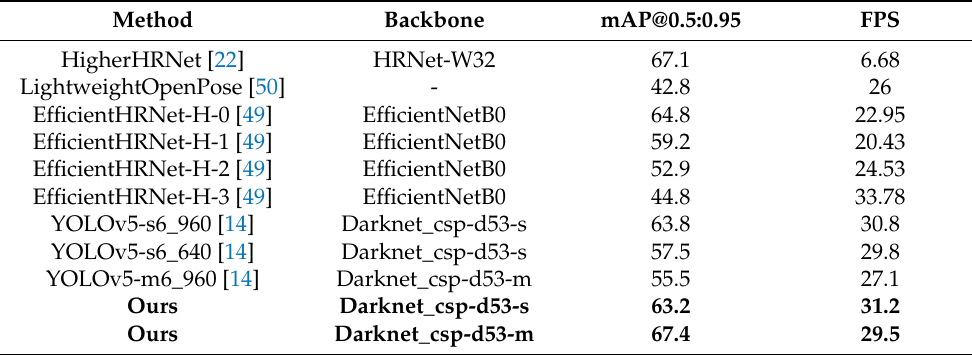
Table 4. Comparison of Network FPS and Average Accuracy between Our Model and Other Models on COCO 2017.